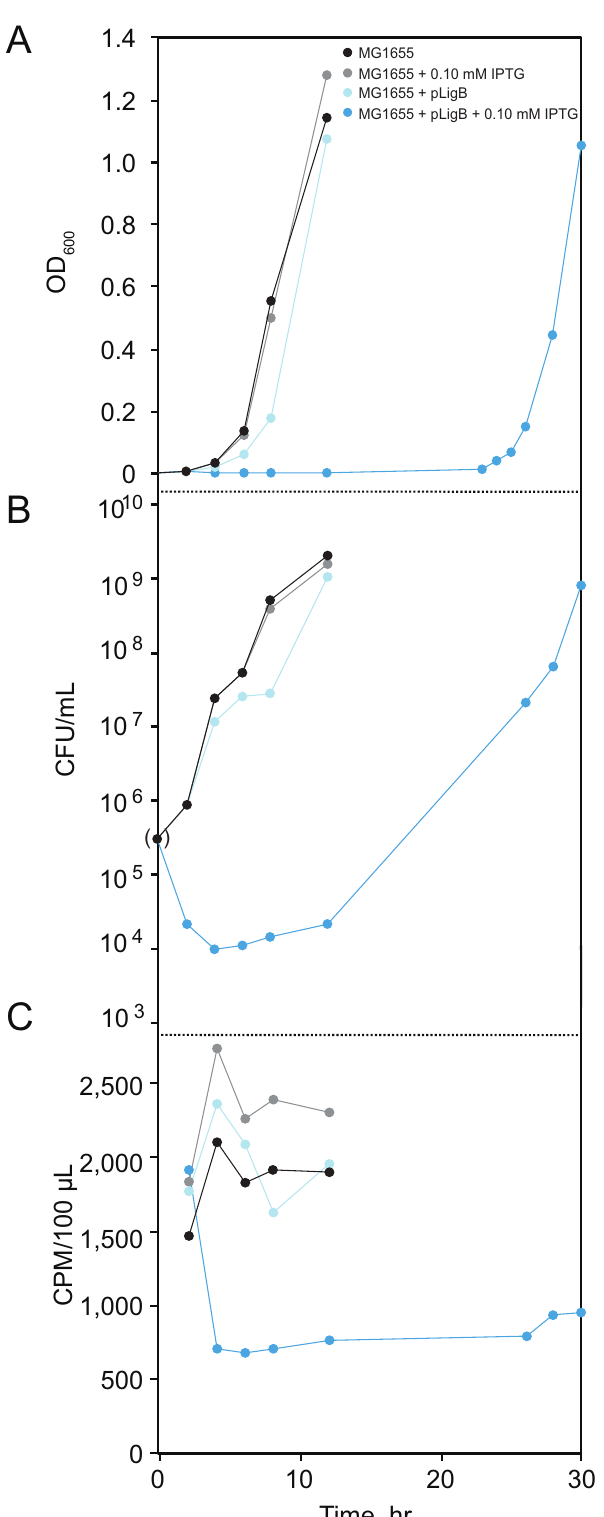
Fig 4. Effect of lig B overexpression on DNA replication and viability. The experiments shown in A,B, and C were performed concurrently. Effect of ligB overexpression on (A) bacterial growth, (B) cell viability(value